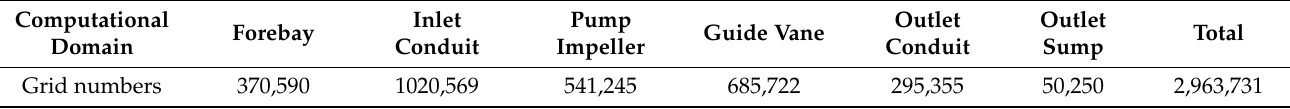
Table 2. Grid numbers of each calculation